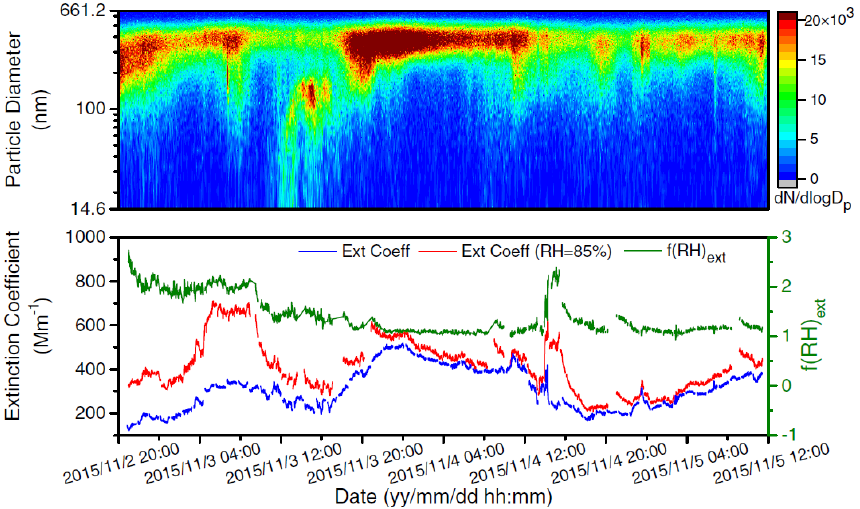
Figure 25. Aerosol properties measured at Hefei Radiation Observatory. Upper panel: aerosol number size distribution of submicrometer particles; lower panel: extinction coefficient of submicrometer particles under dry conditions (blue curve, left y axis) and at 85% RH (red curve, left y axis) and optical growth factors at 85% RH (green curve, right y axis). Reprint with permission by Zhao et al. (2017). Copyright 2017 Optical Society of America.